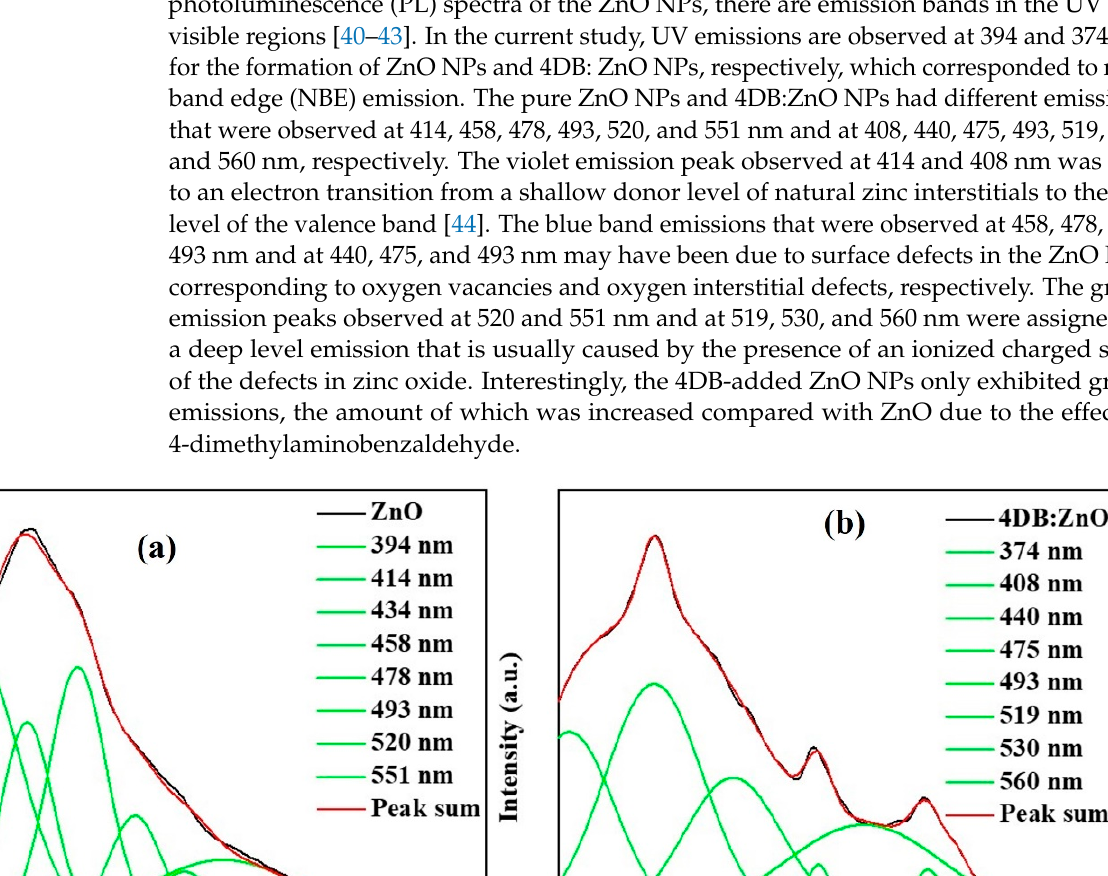
Figure 6. Structures of ( a ) Zn 8 O 8 and ( b ) Zn 8 O 8 :4DB clusters and energy gaps of frontier molecular orbitals of the Zn 8 O 8 and Zn 8 O 8 :4DB clusters.